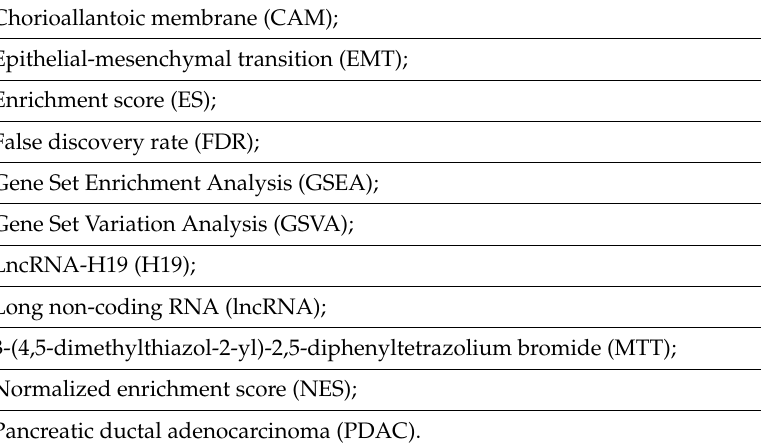
H19 inhibitor, Figure S3: In silico identification of 17 H19-related candidate genes, Figure S4. Original, crude Western blot images with molecular weight markers, Figure S5: Treatment scheme, Figure S6: siH19, siA3G or sulforaphane treatment did not induce side effects in